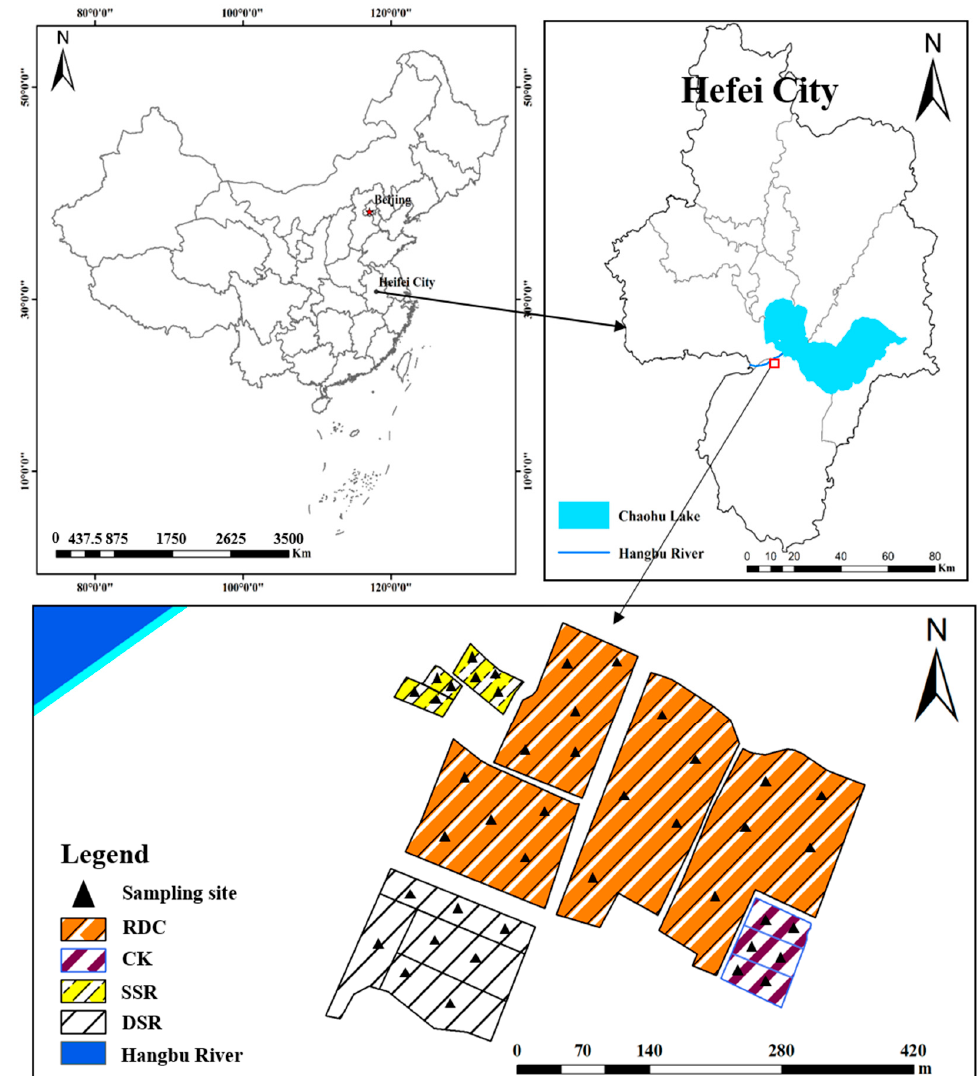
Figure 1. The study area and sampling sites.